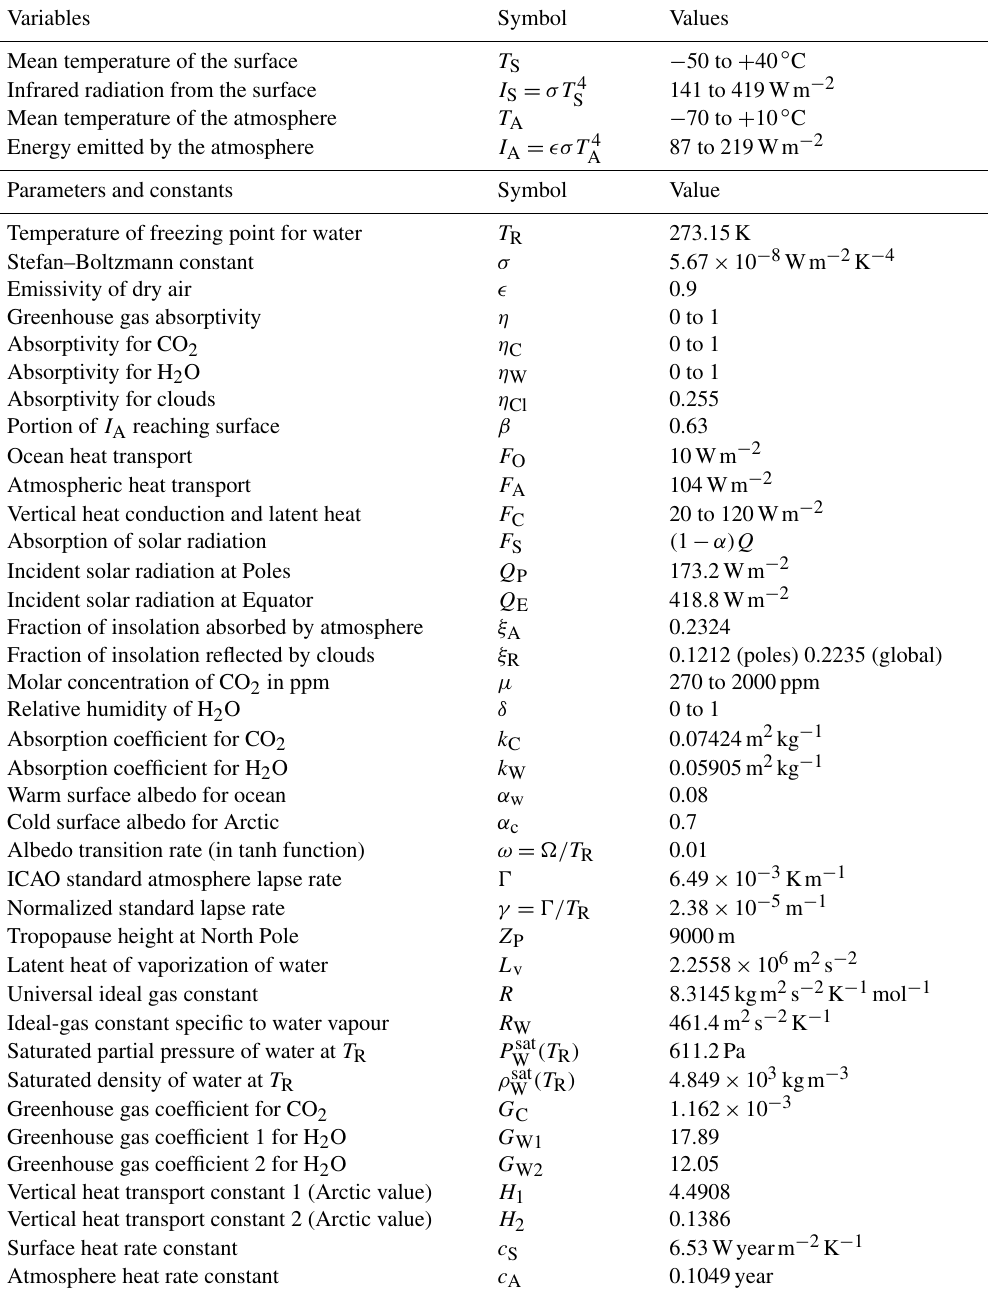
Table 1. Summary of variables and parameters used in the EBM. The values of the physical constants ( ξ a , ξ R , k C , k W , G C , G W1 , G W2 ) are as determined in Kypke (2019) and Dortmans et al.